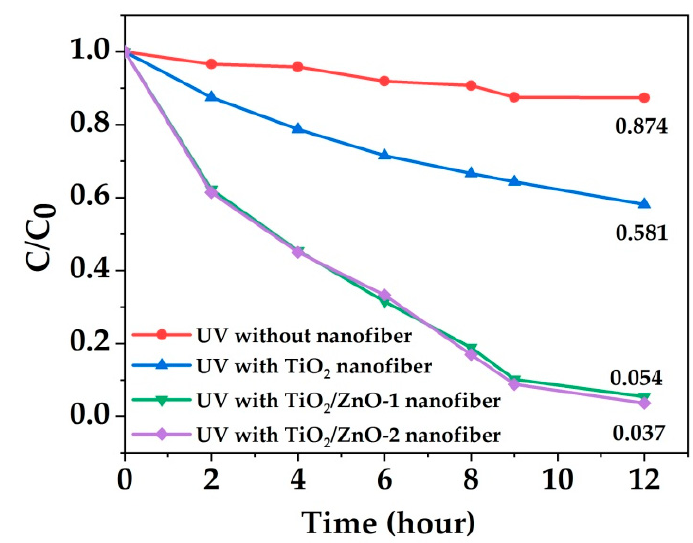
Figure 12. Photodegradation e ffi ciency of TiO 2 / ZnO nanofibers under UV irradiation for the decomposition of methylene blue.